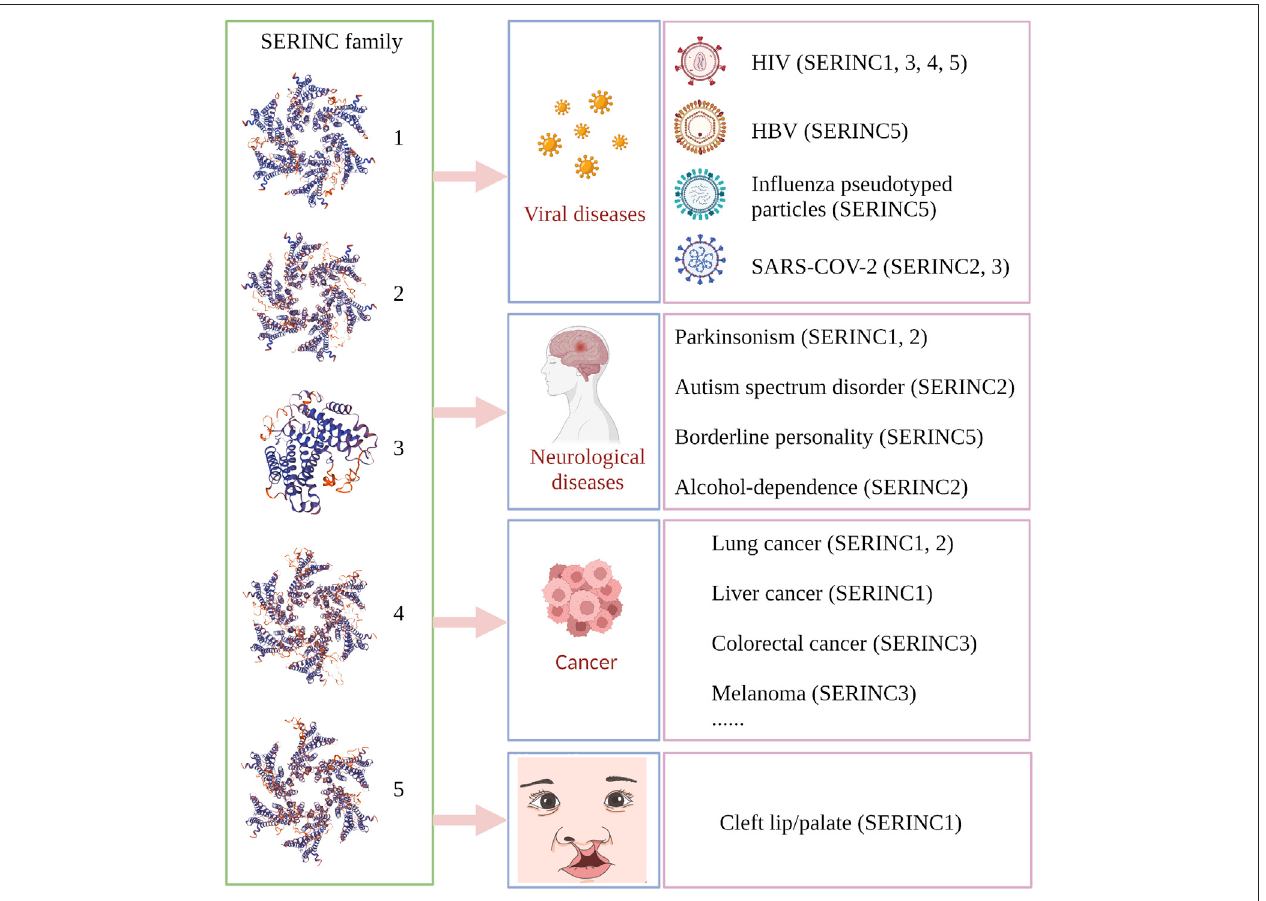
FIGURE 2 | Summary of SERINC-related diseases in human and animal models. Virus-related diseases include acquired immunode fi ciency syndrome (HIV; SERINC1, 3, 4, 5), in fl uenza-pseudotyped particles (SERINC5), COVID-19 (SERINC2, 3), and viral hepatitis type B (HBV) (SERINC5). Nerve-related diseases include seizureParkinsonism(SERINC1,2),autismspectrum disorder(SERINC2),borderlinepersonality (SERINC5), andalcoholdependence(SERINC2). Cancertypesinclude lung cancer (non-small cell lung cancer and lung adenocarcinoma; SERINC1, 2), liver cancer (SERINC1), colorectal tumor (SERINC3), and melanoma (SERINC3), among others. Animal models include rabies virus (RABV), testicular tumor, and nonobese diabetes. Cleft lip/palate is associated with SERINC1. (Created by Biorender.com).